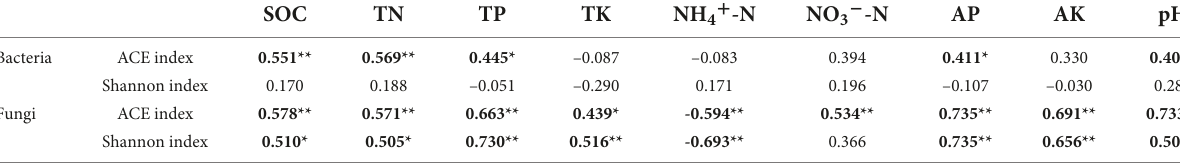
TABLE 3 Spearman correlation coefficient between soil properties and soil microbial alpha-diversity.